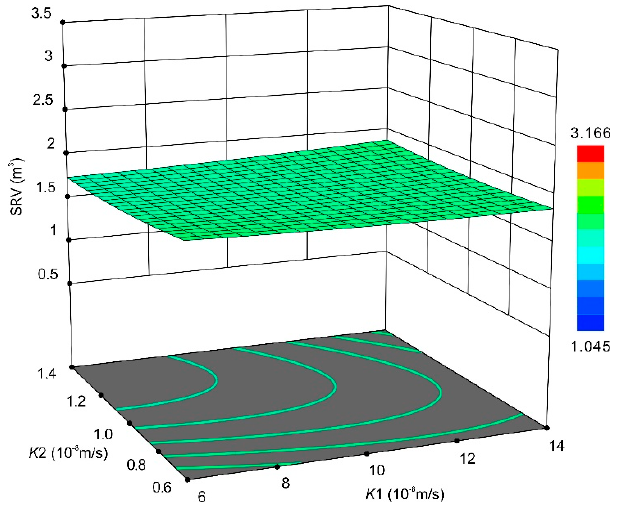
Figure 17. Response surface of the interaction between K 1 and K 2 to SRV.